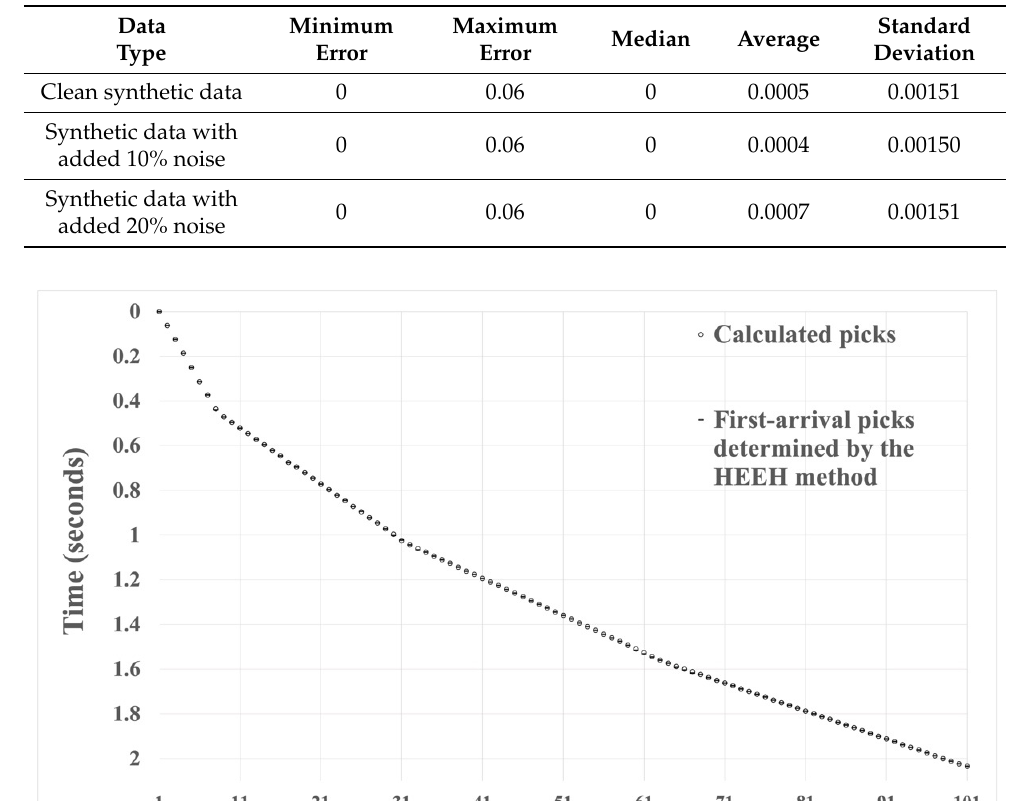
Table 1. Basic statistical parameters of the absolute error values (in seconds) for the synthetic da- taset.